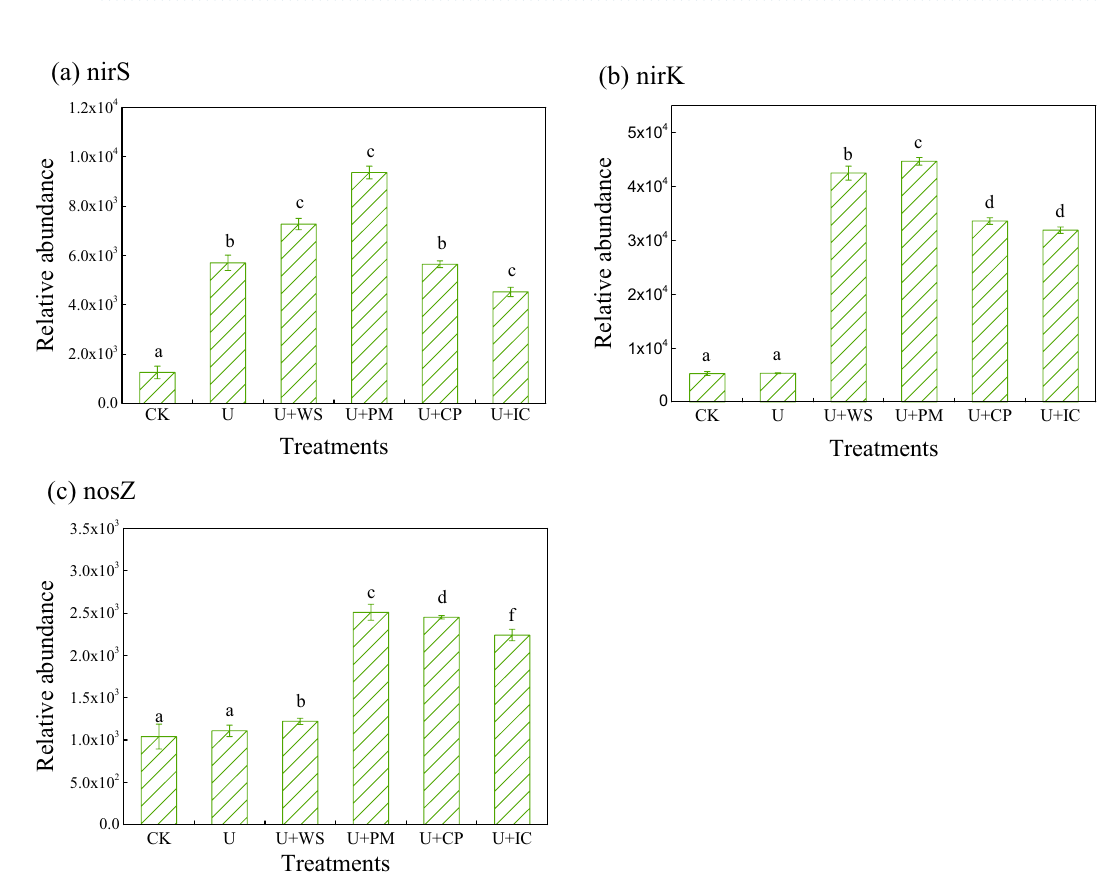
Figure 2. Relative abundance of denitrification genes during the incubation affected by different OAs. Error bars indicate standard deviations (n = 3). The different letters indicate significant differences (P < 0.05) (nirS ( a ); nirK ( b ); nosZ ( c ); CK no urea and OAs, U urea, U + WS urea plus wheat straw, U + PM urea plus pig manure, U + CP urea plus compost, U + IC urea plus improved